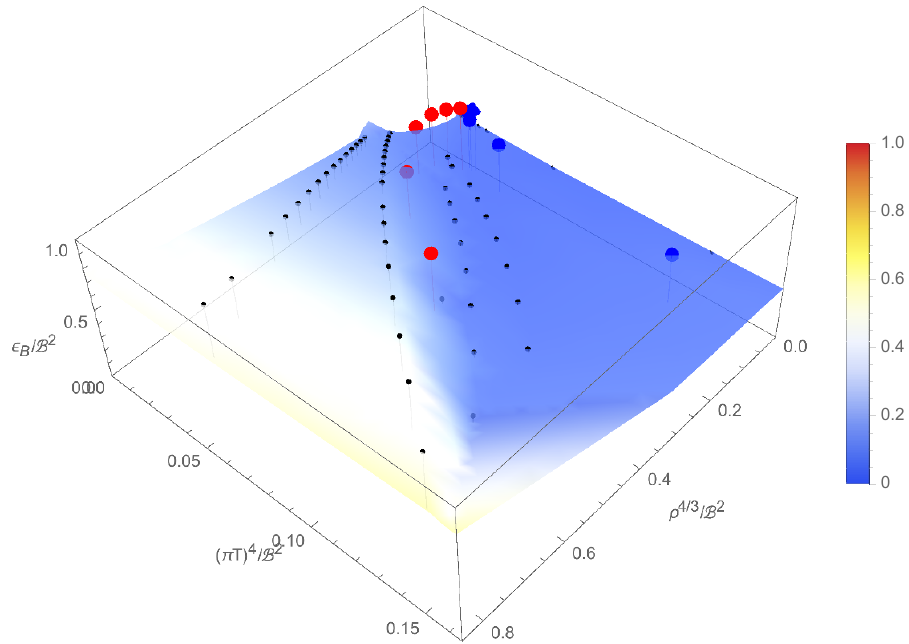
Figure 4 . Physically distinct charged magnetic black branes are uniquely labeled by dimensionless 2 , ( πT ) 4 / 2 and ρ 4 / 3 / 2 [62]. This figure shows a 3D-plot of that scale invariant ther- ratios, (cid:31) / B B B B modynamic data. Black small dots are equilibrium data generated with a shooting method (charged magnetic black brane code), the surface indicates the (rough) interpolation of this equilibrium data. Large red ( ρ = 78% ρ , = 0 . 75 , 1 , 1 . 5 , 2 , 2 . 5 , 3) and blue ( ρ = 30% ρ e B indicate data extracted from late time behavior of our fully dynamical